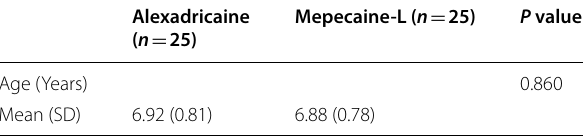
*Significant at P